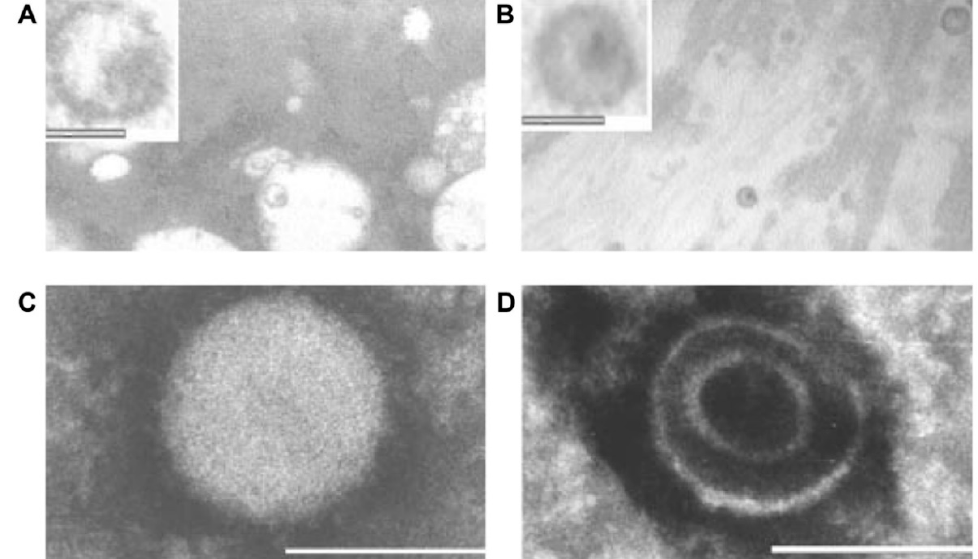
Figure 5. Electron microscopy studies reveal virus-like particles ex vivo and in vitro in samples from patients with PBC. ( A , B ) Freshly isolated biliary epithelial cells from a PBC patient showing virus- like particles in the extracellular space with a distinct envelope and electron-dense core (Inset shows particle at 5× magnification; white bar represents 100 nm). ( C , D ) Similar particles ranging in size from 110 to 120 nm and showing features consistent with B-type particles were observed in nega- tively stained pellets from PBC-conditioned media in BEC supernatants. The negative stain has pen- etrated the structure in panel D to reveal the nucleoprotein core. Copyright 2003 National Academy of